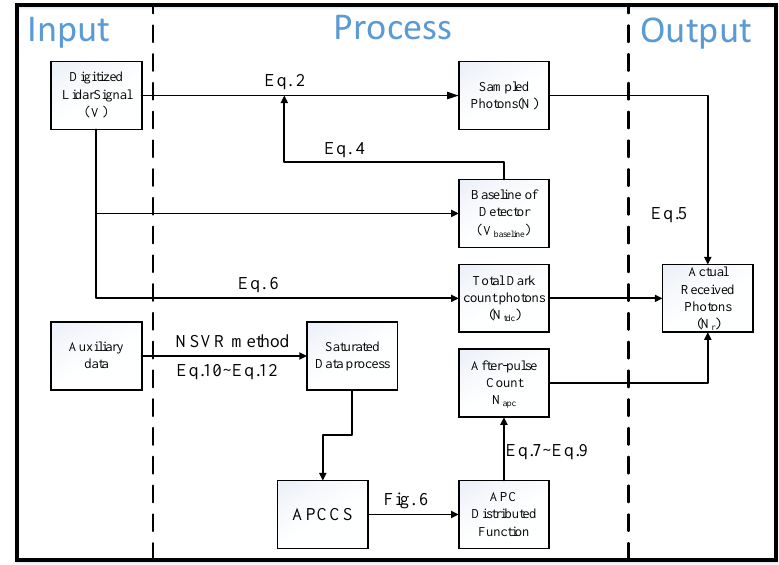
Figure 10. Diagram of data process.